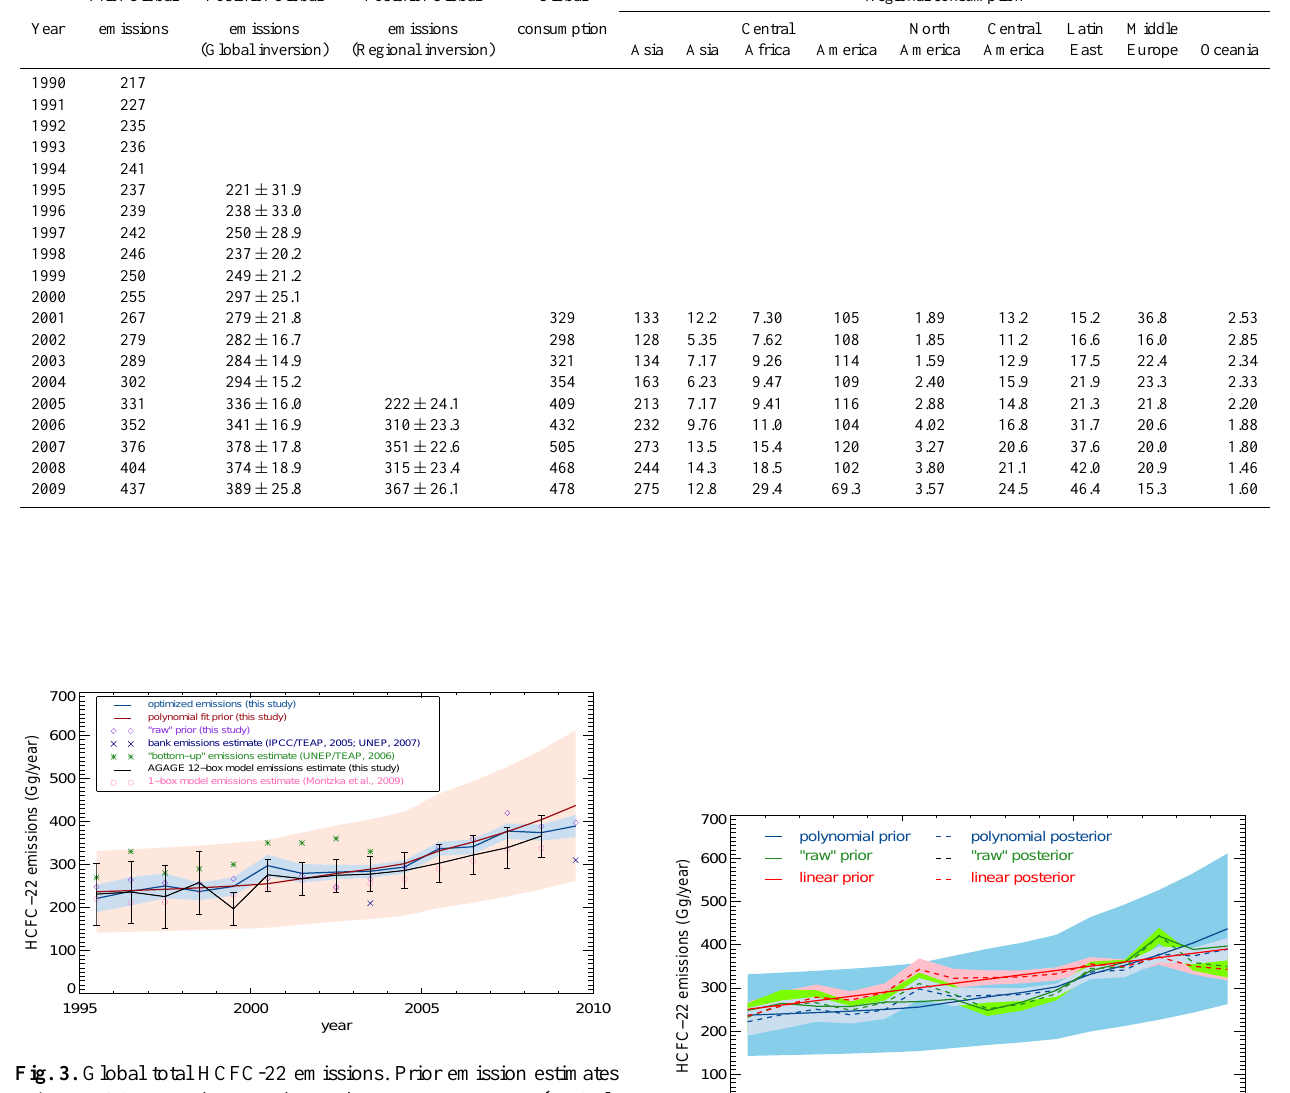
Fig. 3. Global total HCFC-22 emissions. Prior emission estimates using EDGAR v4, the growth rate between 1990–2000 (McCul- loch et al., 2003), and HCFC-22 consumption between 2001–2009 (UNEP, 2011) are shown in diamonds. Polynomial fit of these “raw” prior values that we used in our global inversion are shown as a red line with a shaded (pink) 40% uncertainty range. Optimized emis- sions from this study are shown in blue with our calculated posterior uncertainty. Previously published bank emission estimates (blue crosses) (IPCC/TEAP, 2005; UNEP, 2007), “bottom-up” emission estimates (green stars) (UNEP/TEAP, 2006), 1-box model emis- sion estimates (pink circle) (Montzka et al., 2009), as well as new AGAGE 12-box model emission estimates (black line) are also shown for comparison.